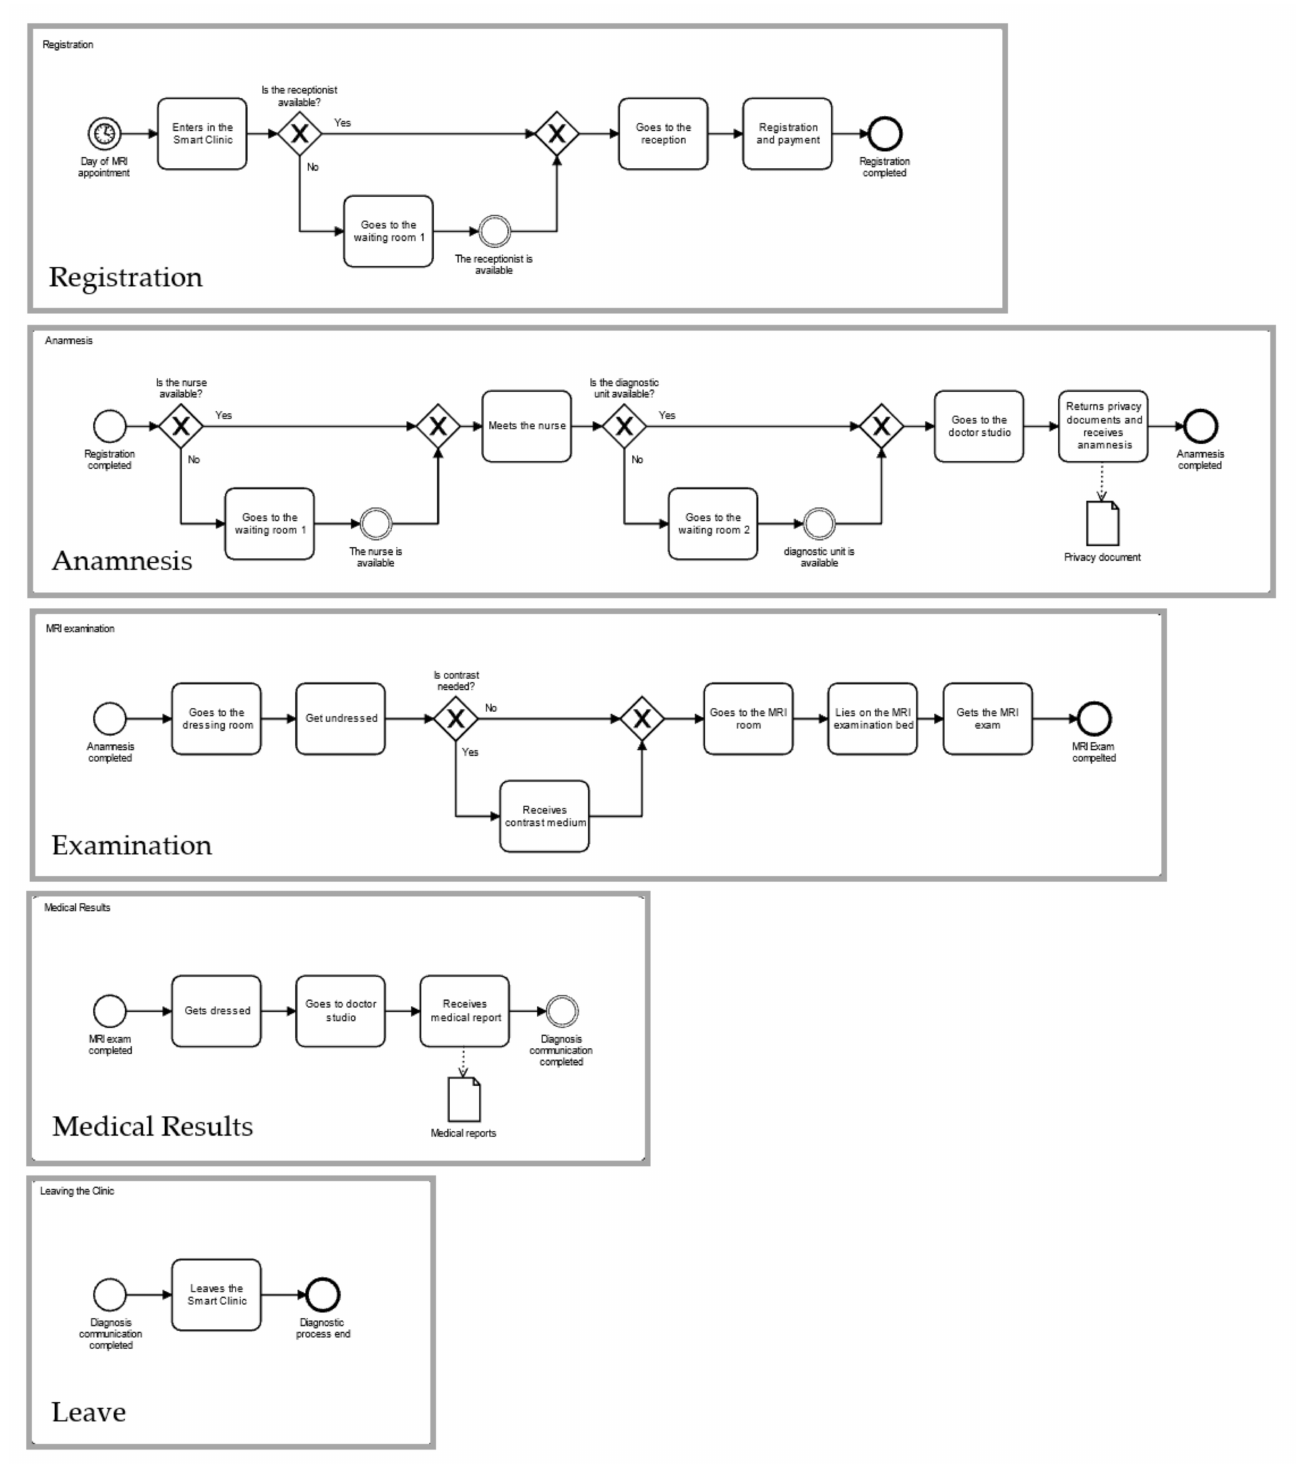
Figure 2. Patient macro-activities of the MRI examination process. The process begins on the day of the diagnostic inspection. The patient enters the medical facility and reaches the acceptance desk. There, the individual is enrolled by the receptionist and pays for the service. At the end of the registration, the patient is escorted by the nurse towards the doctor’s studio, where the preliminary consultation takes place; the physician gathers information about the patient’s medical history and collects the written informed consent (given by the receptionist on the day of the appointment